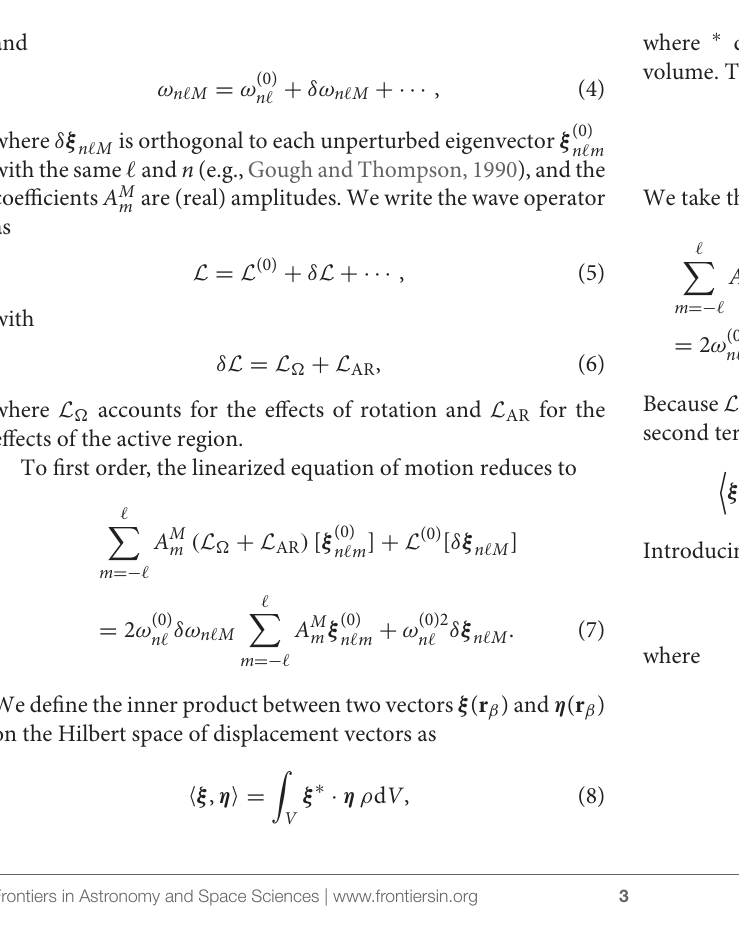
R β . The frame R is the inertial frame of R β corotate with the active region (shaded area) b R β it is at the b b